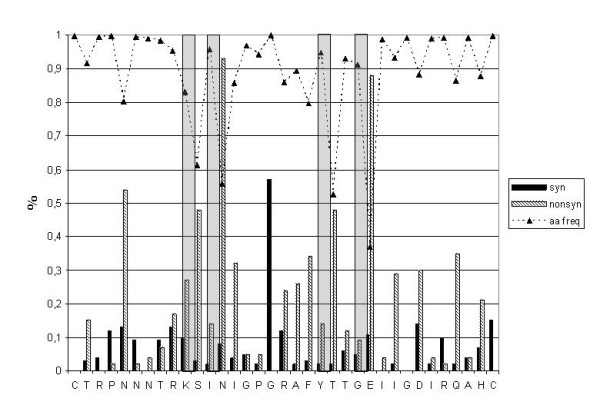
Evolution pattern of the V3 loop. The percentage of synonymous and non-synonymous substitutions in each of the 35 codons of the V3 Loop are indicated, together with the percentage of amino acid residue preservation at the specific position. The positions where the residue is found in < 80% of the sequences, are highlighted with light-gray boxes.